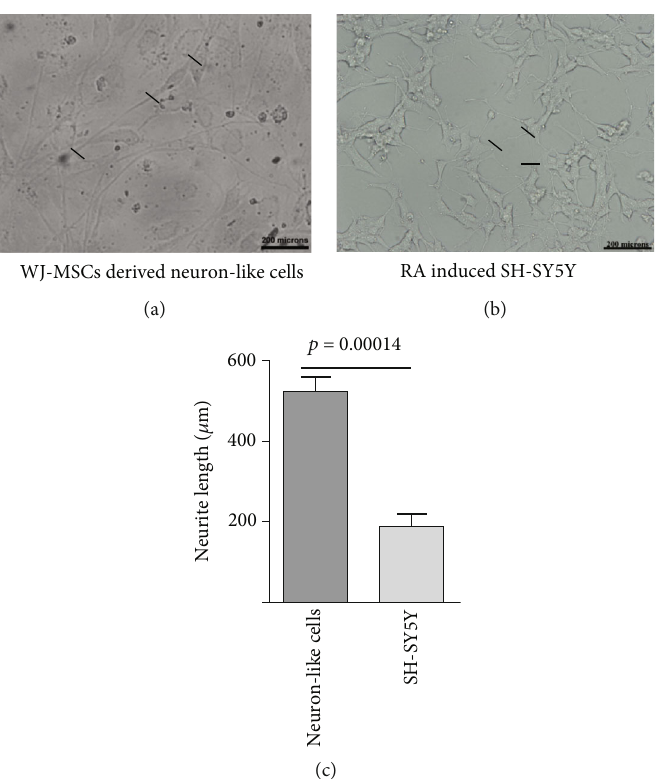
Figure 6: Morphometric analysis of WJ-MSCs derived neuronal-like cells and di ff erentiated SH-SY5Y cells. Panel A shows the representative bright- fi eld image of neuronal-like cells generated from WJ-MSCs, whereas Panel B shows the representative bright- fi eld image of SH-SY5Y cells di ff erentiated with ATRA. Scale bar: 200 μ m. Panel C represents the quantitative values of the neurite length ( mean ± SEM , n = 3